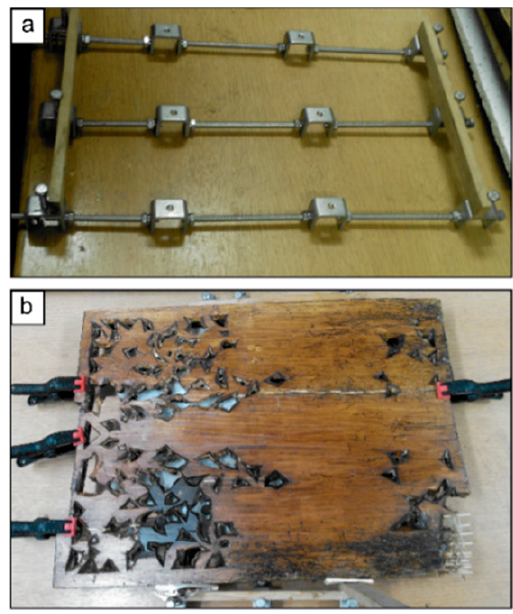
Figure 4. Consolidation in the volume phase of the weakened support: ( a , b ) Injection; ( c ) Brushing the Paraloid solution B 72.